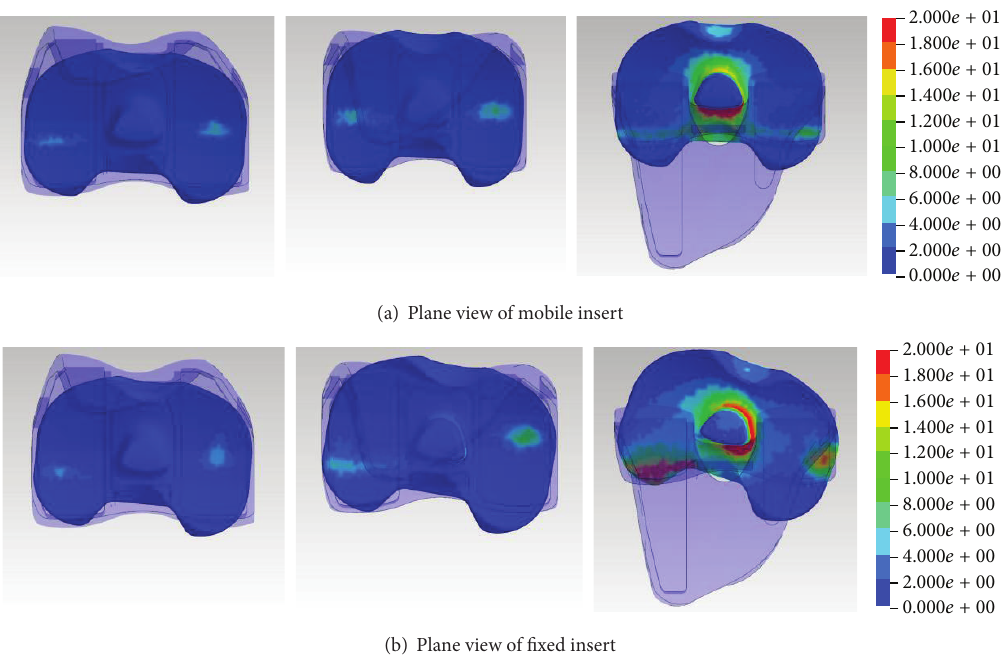
Figure 5: Shear stress distribution on the plane views of mobile and fixed inserts at 30 ∘ , 60 ∘ , and 120 ∘ of flexion angle, respectively, depicting the shear stress distribution. The fringe level is displayed in the unit of